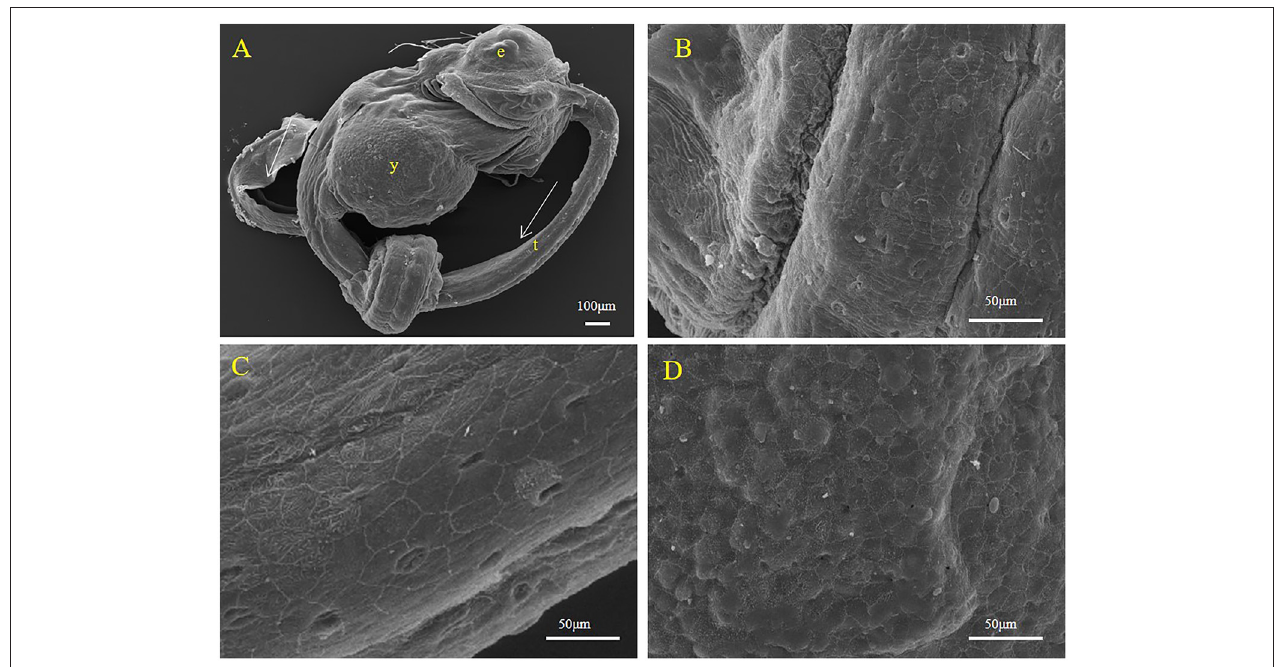
FIGURE 6 | Representative SEM images of the body surface of larval S. schlegelii . (A) The complete morphology of a larva. (B) The partialof a larva. (C) Surface epithelium of fish. (D) An area bulging with yolk droplets. Eyes (e), tail (t), and yolk (y) can be observed. Scale bars, 100 µ m (A) ; 50 µ m (B–D)